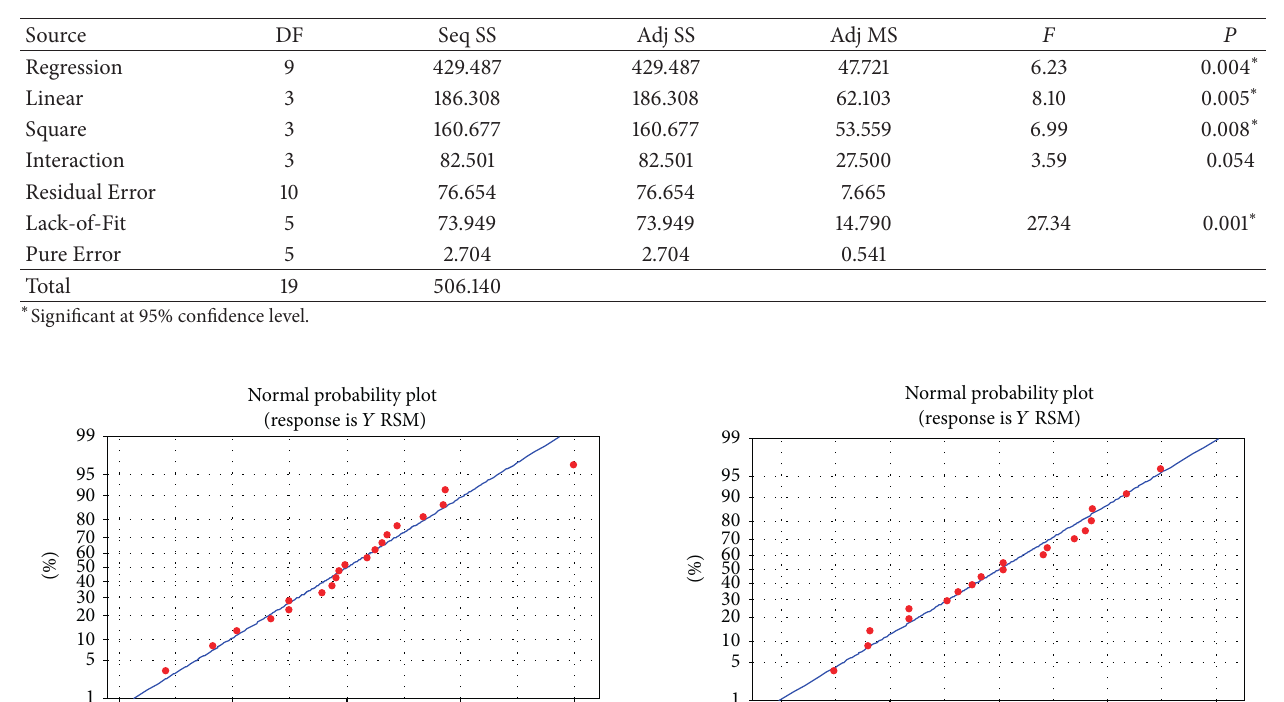
Table 5: ANOVA for % recovery.